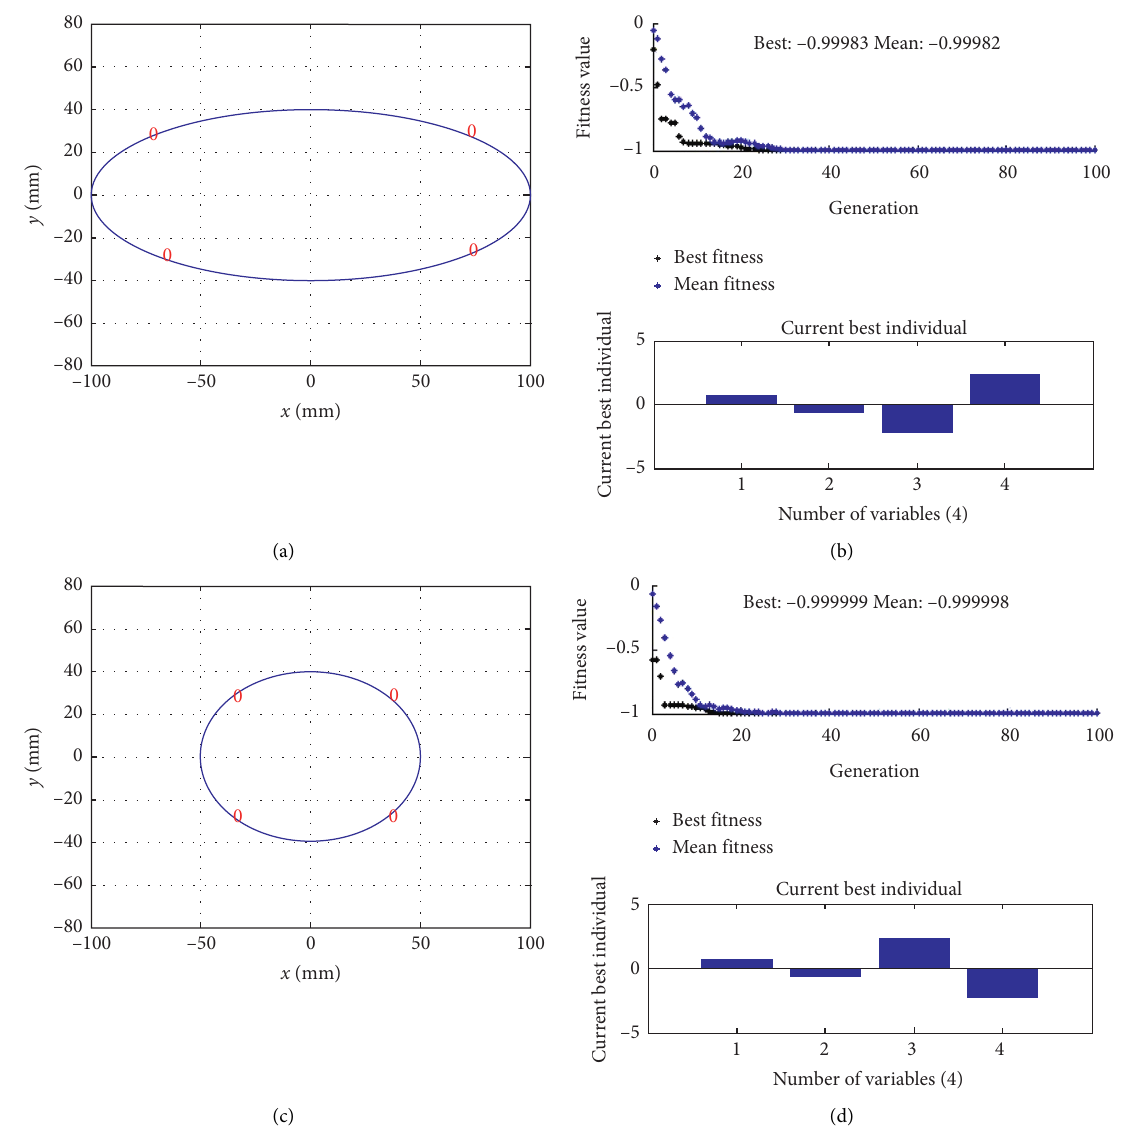
Figure 14: Optimal solution calculation. (a) Ellipse a � 100mm and b � 40mm; the calculated optimal grasp position. (b) Ellipse a � 100mm and b � 40 mm; the upper side is the relationship between the fitness value and generation, and the lower side is the value of variable q in the optimal solution. (c) Ellipse a � 50mm and b � 40mm; the calculated optimal grasp position. (d) Ellipse a � 100mm and b � 40mm; the upper side is the relationship between the fitness value and generation, and the lower side is the value of variable q in the optimal solution. Table 5: Correlation coefficient and standard deviation of the fingertip force